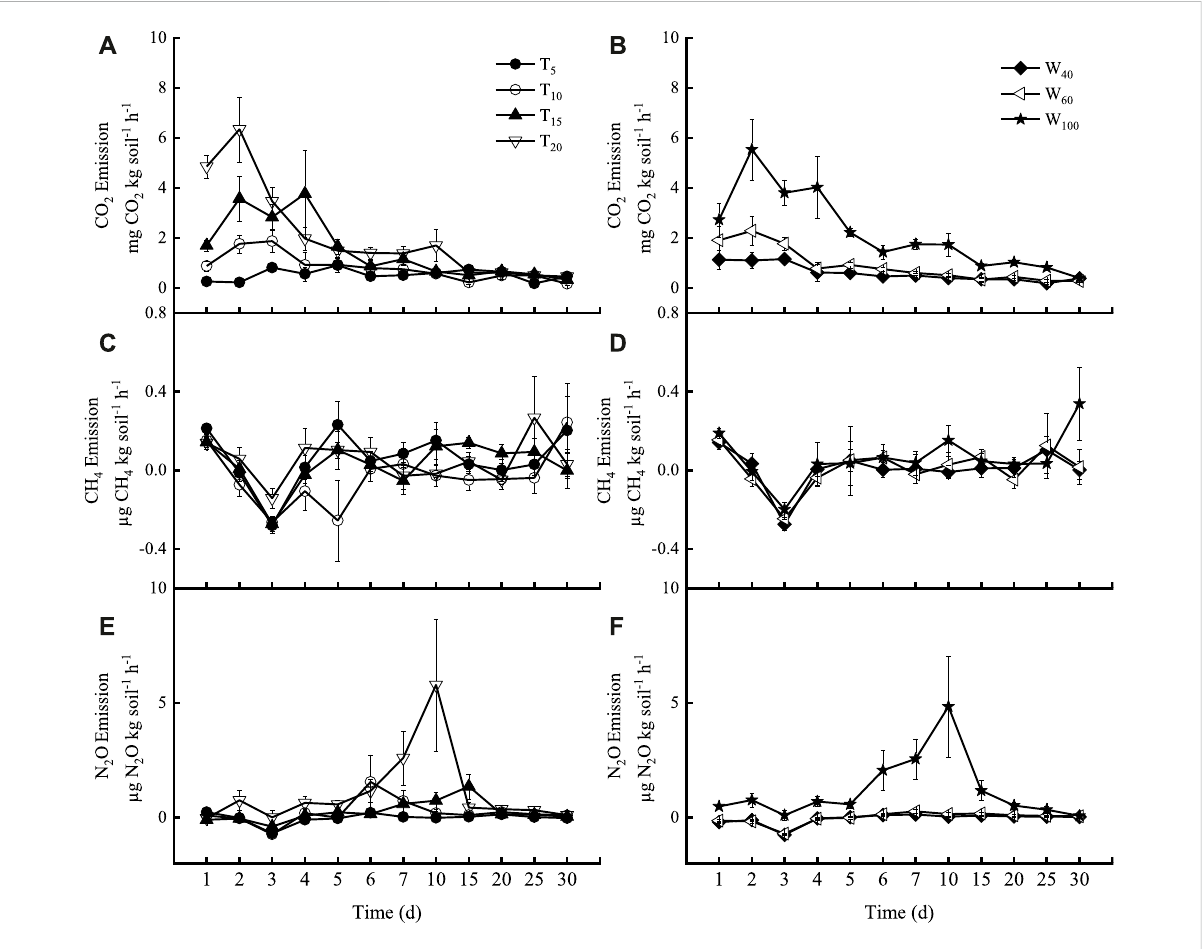
FIGURE 1 Temporal changes in soil CO 2 , CH 4 and N 2 O emission rates. The error bars show standard errors: n = 9 and 12 for temperature and WHC,